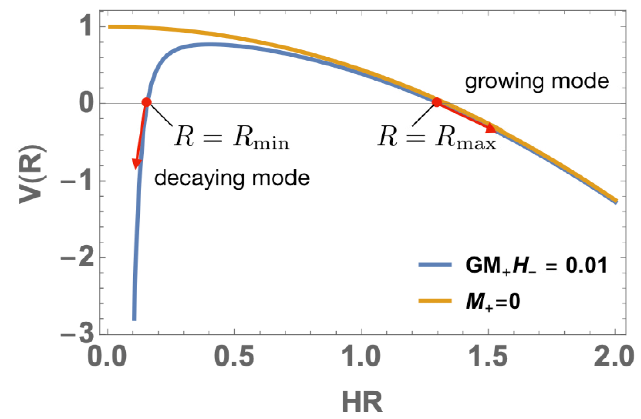
Figure 1 . Plot of the e(cid:11)ective potential V ( R ) with H + = 0 ; M (cid:0) = 0 ; H (cid:0) = H > 0 ; (cid:6) = H= 2, and M + = 0 : 01 = ( GH